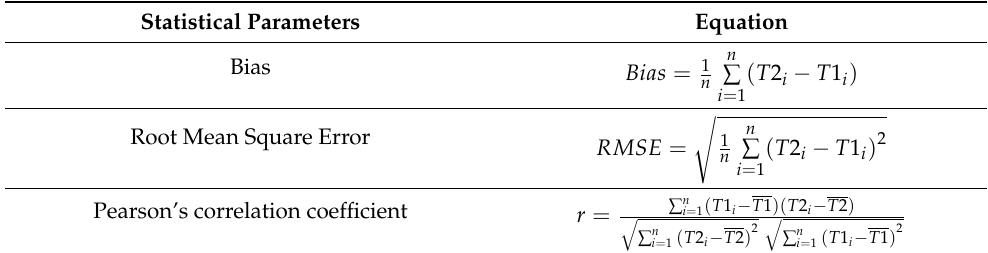
Table 3. Statistics used for comparisons. T presents the variable considered, while the numbers 1 and 2 represent the tower identification. Here n represents the number of records and i is the time index. An overbar represents a time